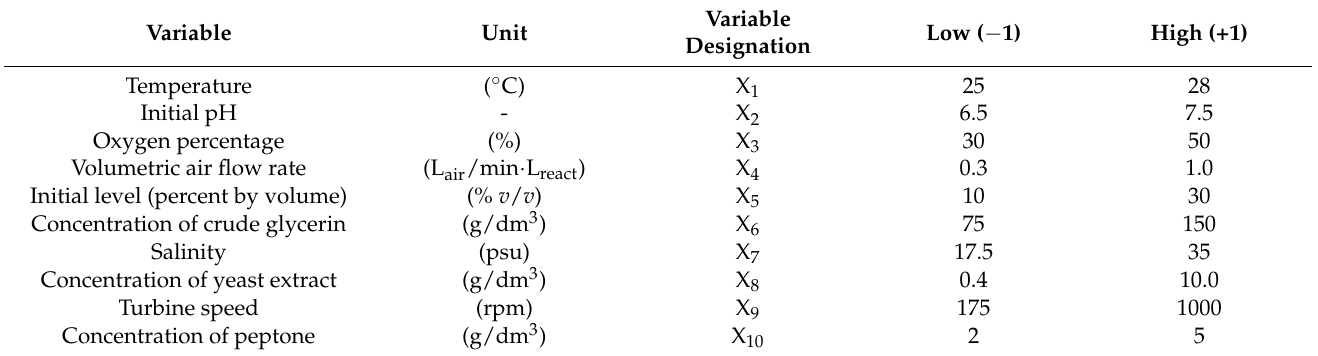
Table 3. Ranges of variables used in the Plackett–Burman design